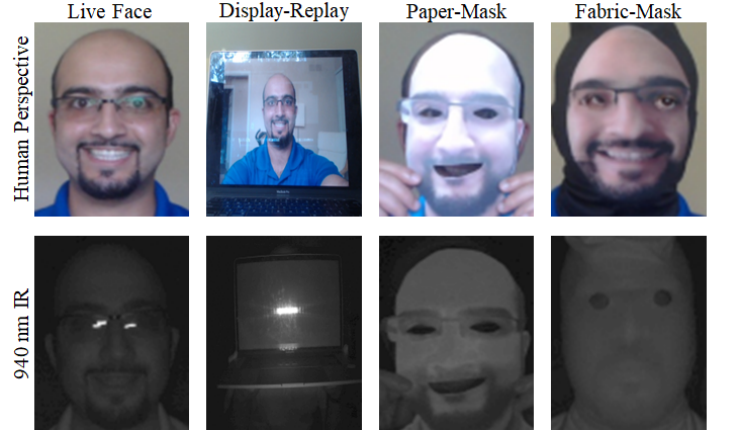
Figure 1. Juxtaposing the human and illuminated near-infrared perspectives. Spoofs have less texture variance and appear brighter to the infrared